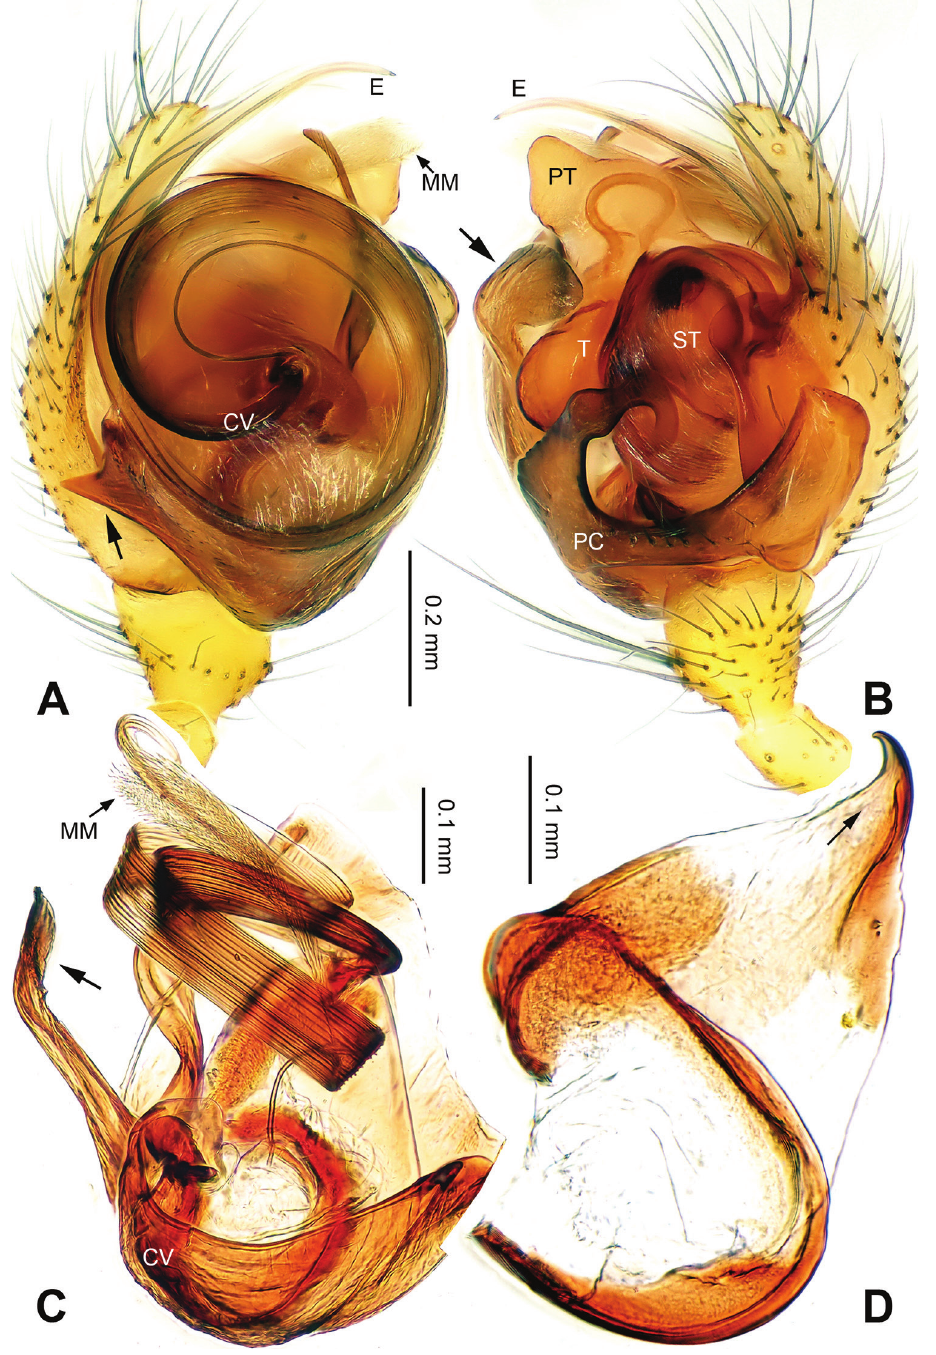
Figure 5. Callosa baiseensis sp. n., male holotype. A Palp, prolateral view B Palp, retrolateral view C Embolic division, retrolateral view D Distal suprategular apophysis, retrolateral view. Scale bars: B as A